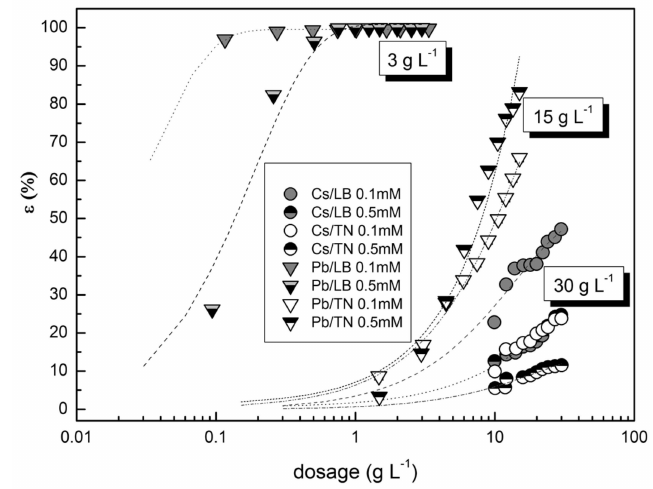
Figure 6. Adsorption e ffi ciency of Cs + / Pb 2 + adsorption on LB and TN in relation to sorbent dosage.